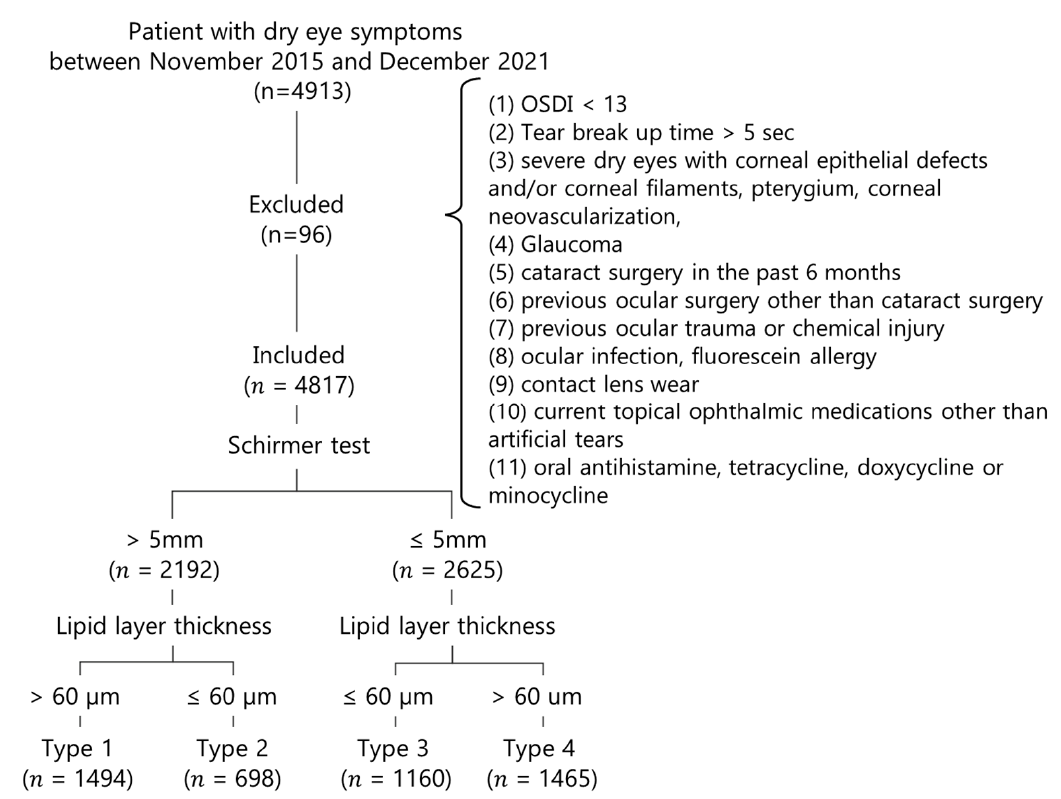
Figure 1. Patient selection flowchart.